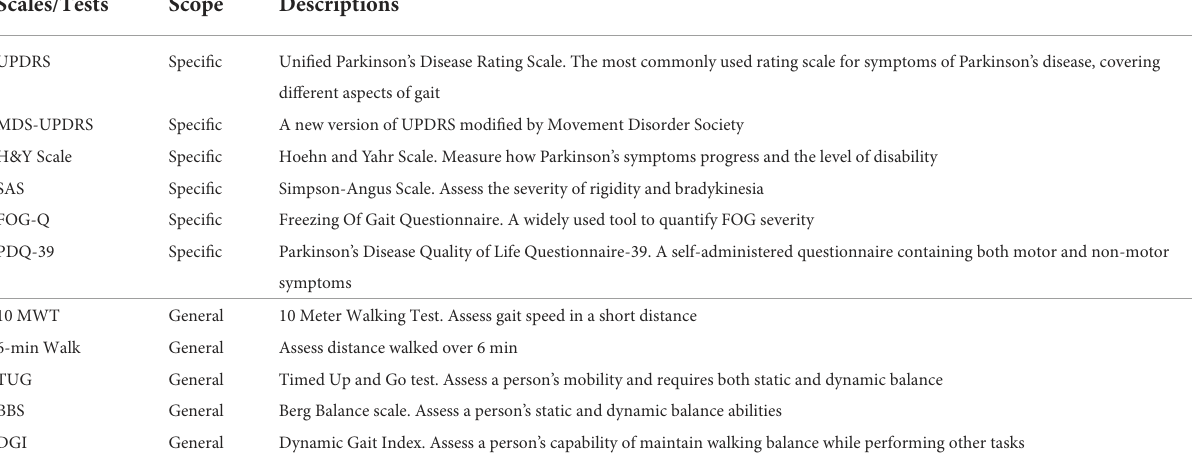
TABLE 2 Clinical scales and tests for assessing the gait performance in